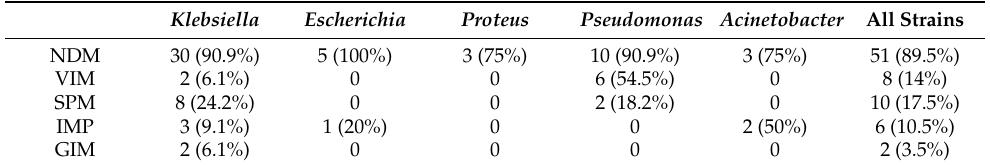
Table 4. Genetic profile of isolated strains.